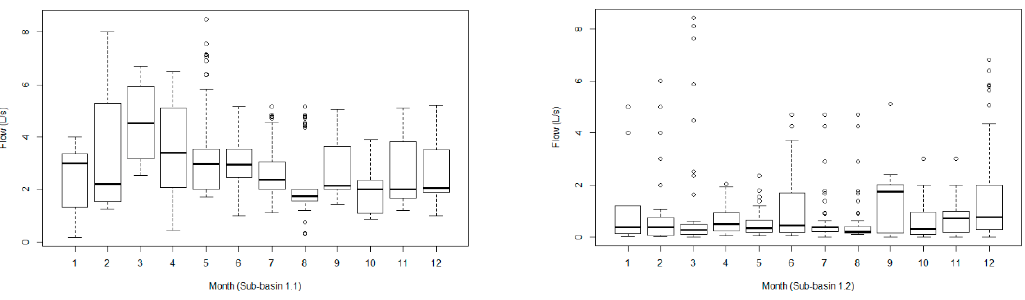
Figure 7. Sub-basins 1.1 and 1.2 discharge flow in the Olaria stream watershed, State of São Paulo, Brazil.